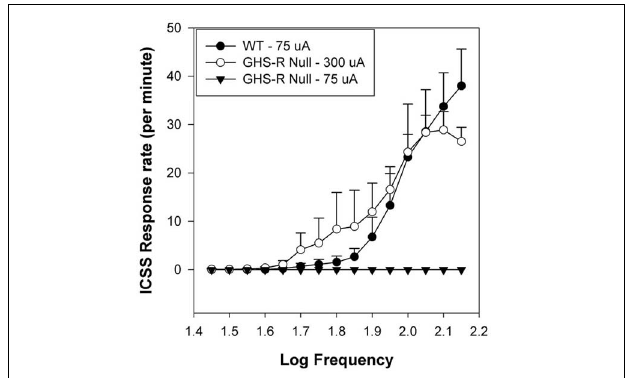
FIGURE 2 | Mean group Intracranial Self-Stimulation (ICSS) rate-frequency scores for wild-type (WT: n = 5) and GHR-R null rats ( n = 6) as a function of stimulation intensity. WT rats tested at 75uA and GHR-R null rats tested at 300uA exhibit overlapping rate-frequency curves. When GHR-R null rats were tested at 75uA, their rate-frequency curves dropped to 0. Figure reprinted with permission from Addiction Biology (Wellman et al.,